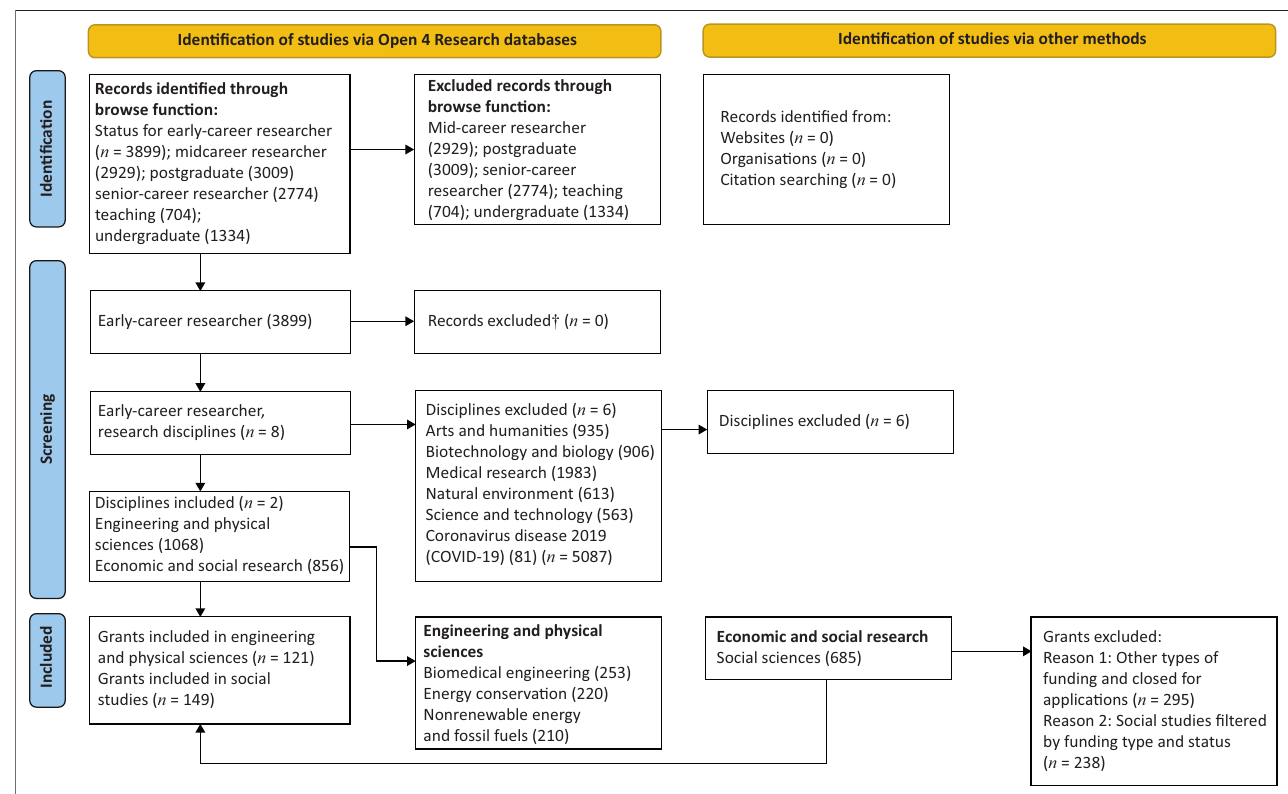
FIG URE 1: Preferred Reporting Items for Systematic Reviews and Meta-Analyses (PRISMA) chart showing the identification, screening and selection of